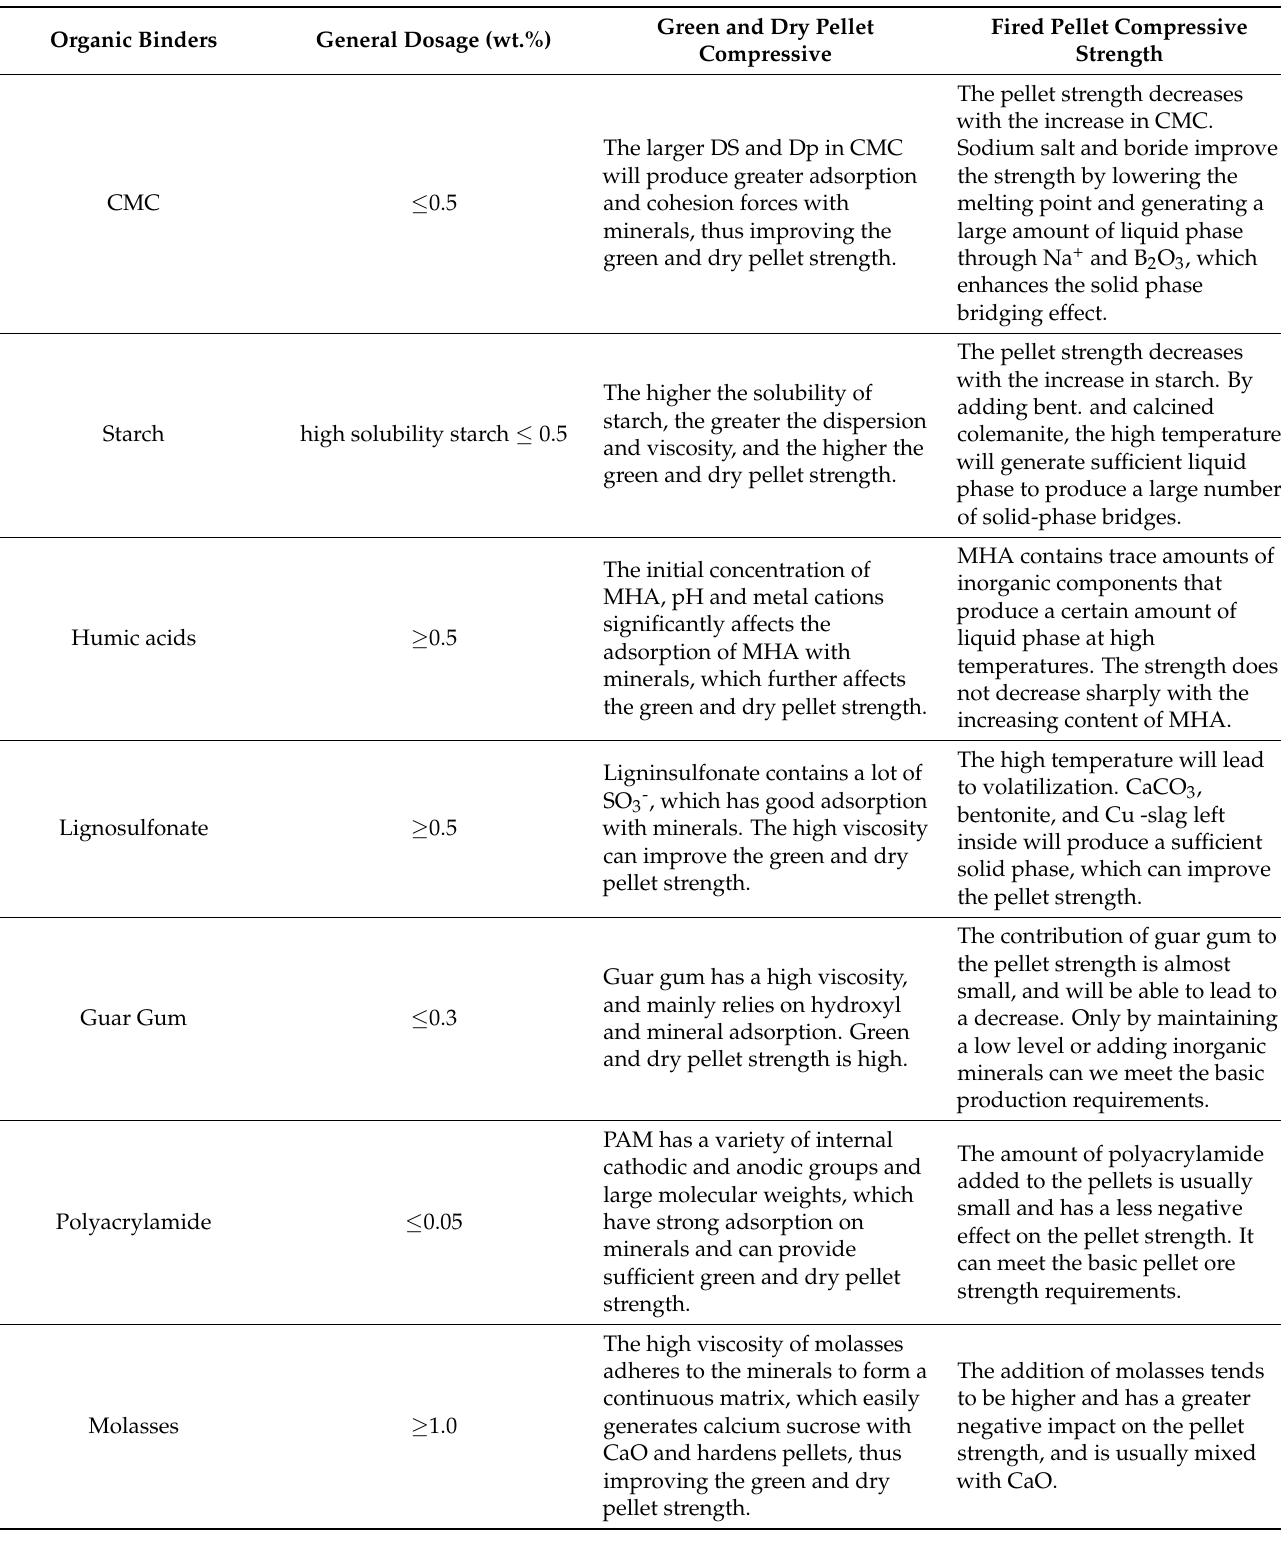
Table 8. Effect of organic polymers on pellet ore